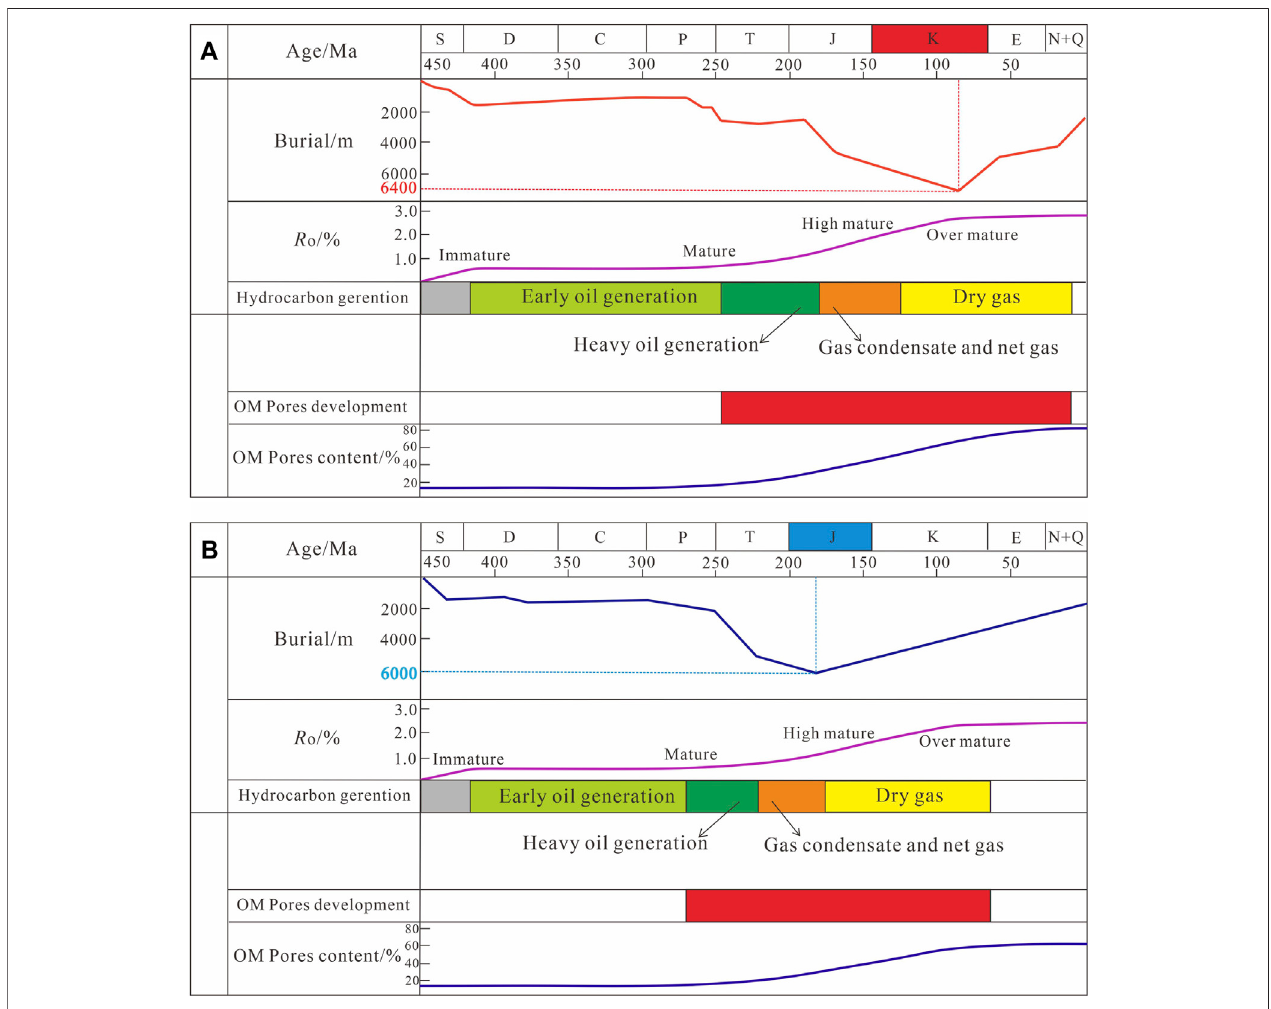
FIGURE 10 | OM pore evolution of the Longmaxi shale in Chongqing and Hunan. (A) Longmaxi shale in Chongqing; (B) Longmaxi shale in Hunan.